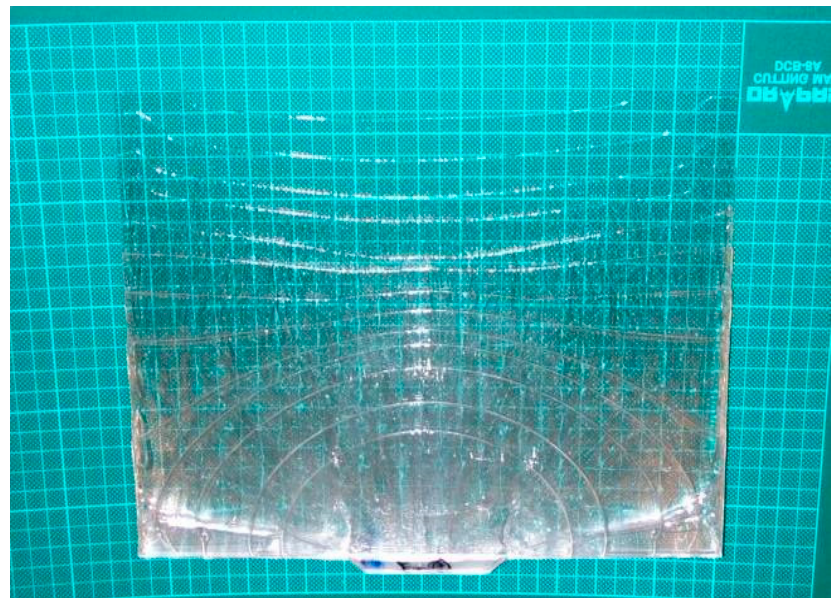
Figure 4. The bad flow situation of light guiding plate on micro-injection molding.